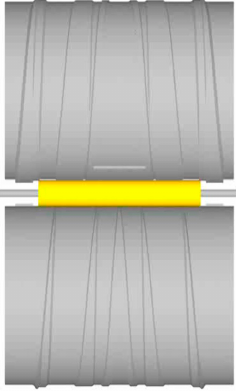
Figure 3. Principle of MSCWR.